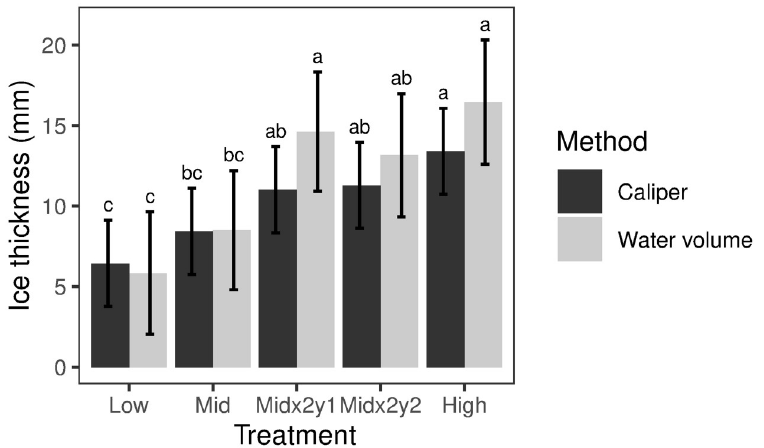
Fig 4. Measured ice thickness using calipers and water volume methods. Different letters denote significant differences among treatments ( P < 0.05). Vertical lines are ± 1 standard error.